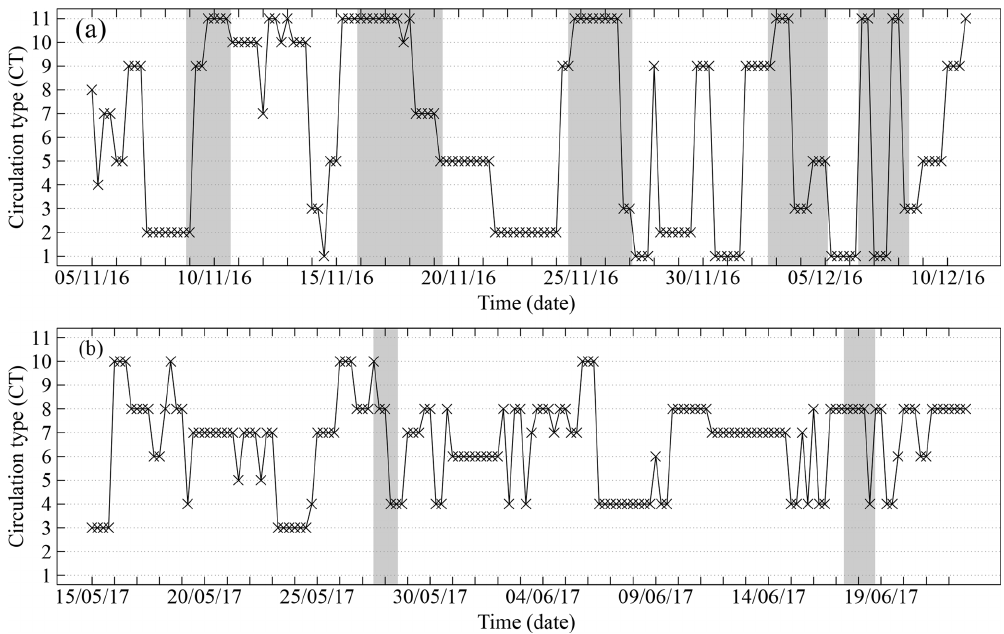
Figure 3. Time series of circulation types (CTs) during the two field campaigns: (a) winter and (b) summer. The 11 CTs are shown in Fig. 2; see text for an additional description. Shading shows the pollution events identified in Sect. 5 and Fig. 5.